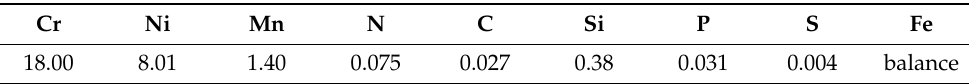
Table 1. Chemical composition of AISI 304 SS (wt